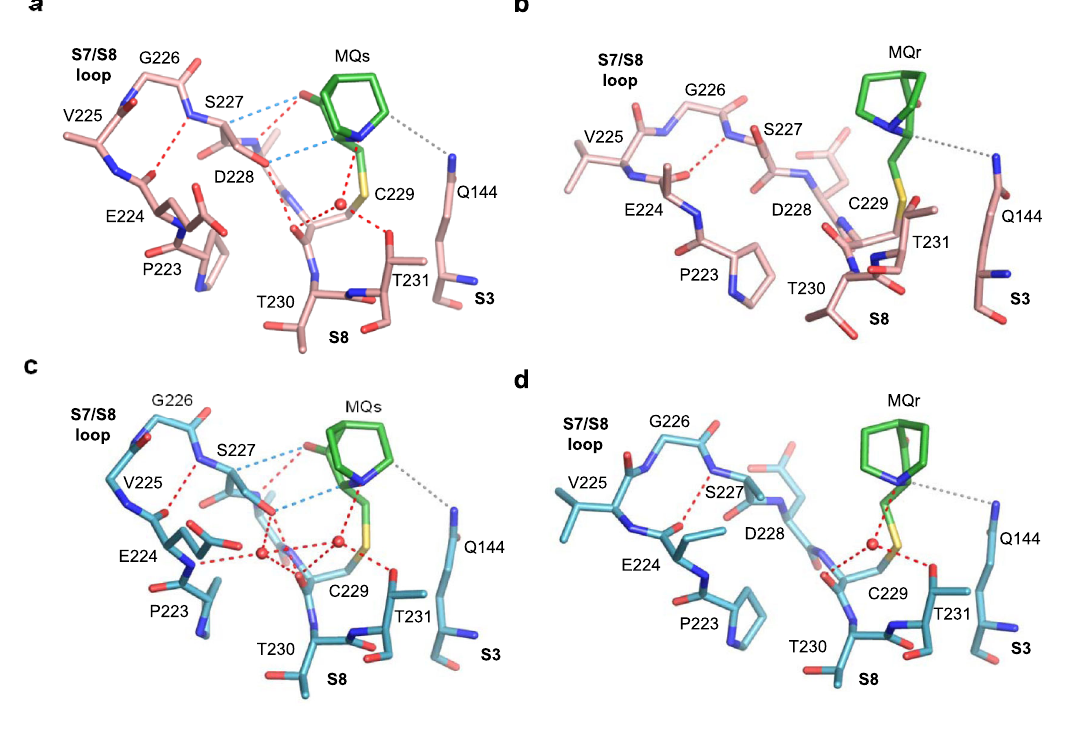
Fig. 2 MQ bound to C229 in R273H and R273C mutants. The MQ-C229 conjugates and intramolecular interactions are from the following crystal structures. a R273H-MQ (I), monomer A. b R273H-MQ (I), monomer C. c R273C-MQ (I), monomer A. d R273C-MQ (I), monomer C. MQ-C229 is located at the C-terminus of S7/S8 loop. Direct and water-mediated hydrogen bonds, and CH···O interactions are indicated by red and blue dotted lines, respectively. Van der Waals (VdW) interactions are in grey dotted lines. Water molecules shown as red spheres. Other structure representations and color codes are as in Fig.